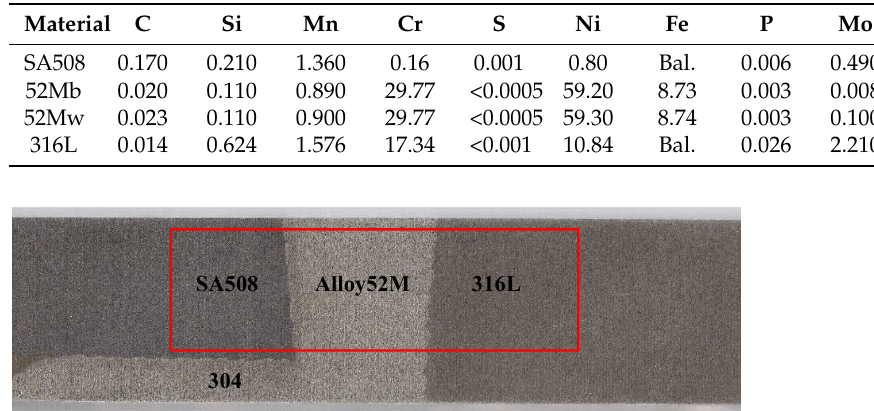
Figure 2. Physical diagram of dissimilar metal welded joints and sampling area. Table 2. Mechanical properties of various DMWJ materials at room temperature